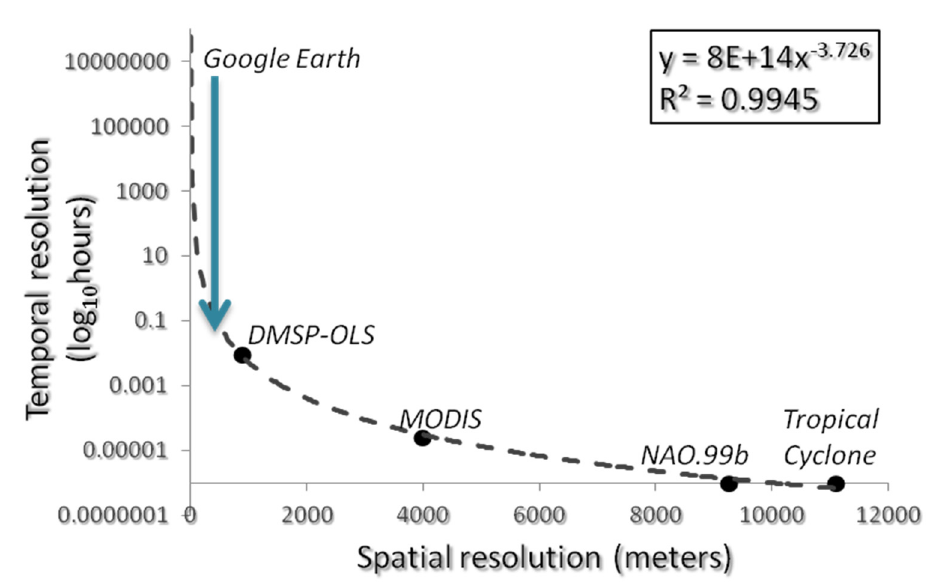
Figure 9. Relationship between the spatial resolution of some investigated factors and the natural logarithm of their temporal resolution. The arrow shows the current Google Earth trend of refining the temporal resolution while maintaining the same high spatial